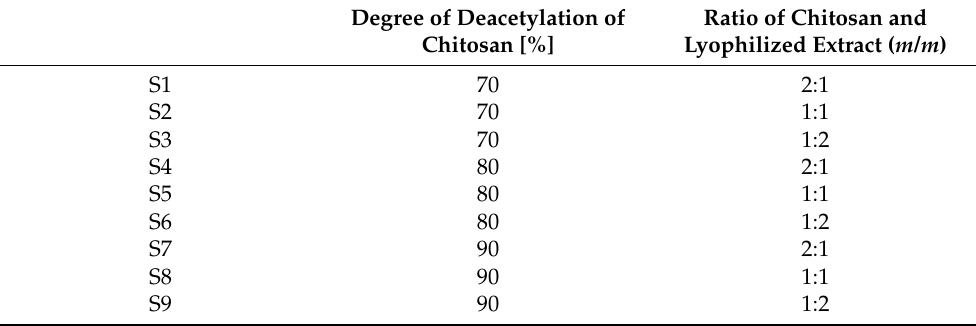
Table 2. Factorial Experiment Plan for the optimization of chitosan